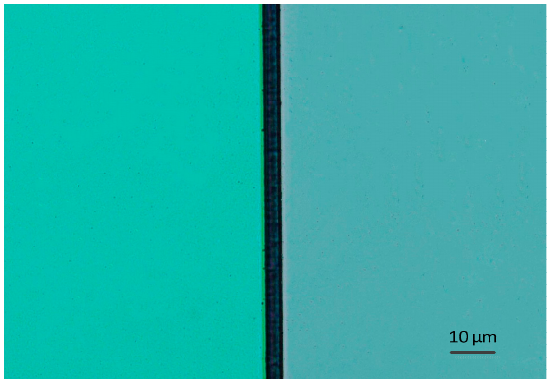
Figure 11. The microscope photos of the joint width between bandpass filter for the region 3.55– 3.75 µm and bandpass filter for the region 4.85–4.95 µm.